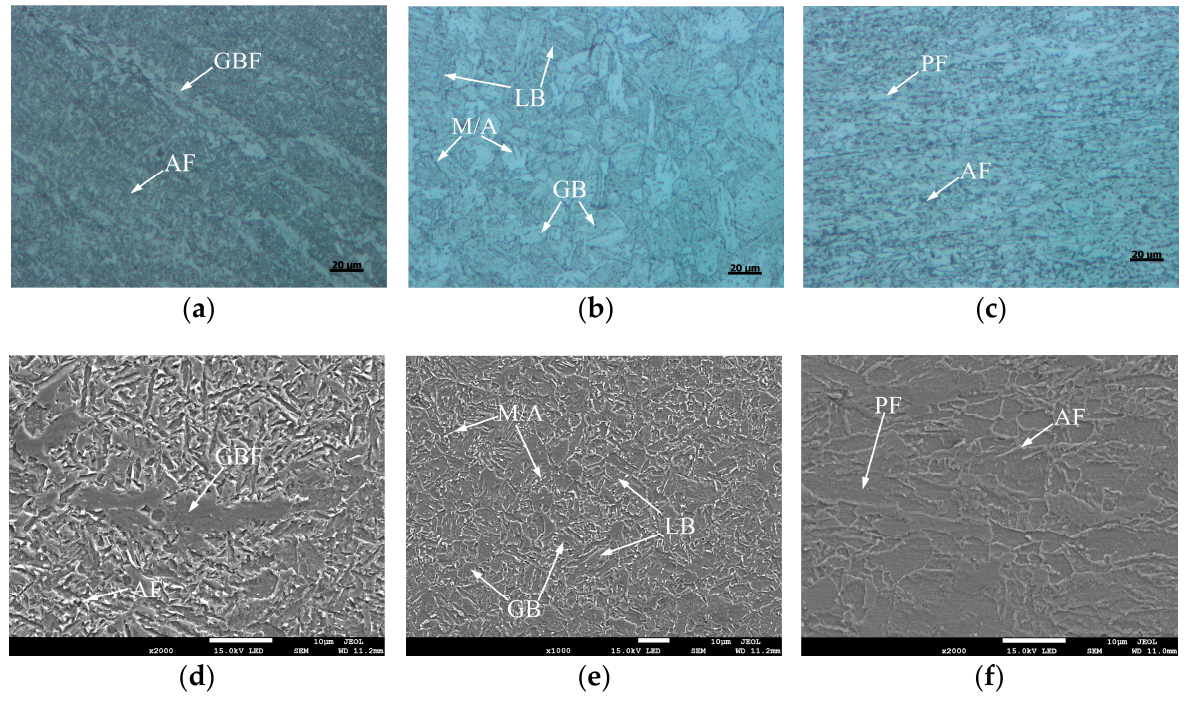
Figure 4. OM of the welded joint at different locations: ( a ) WM, ( b ) CGHAZ, ( c ) SCHAZ; SEM of the welded joint at different locations: ( d ) WM, ( e ) CGHAZ, ( f ) SCHAZ.